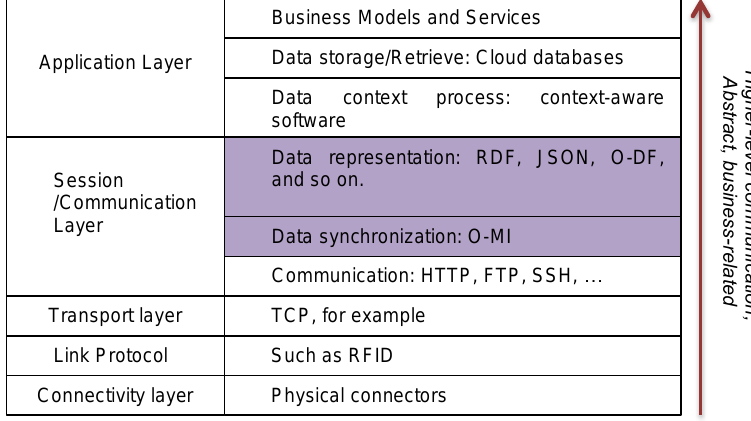
Figure 2. O-MI/O-DF transport layer inside the landscape of IoT data transfer.